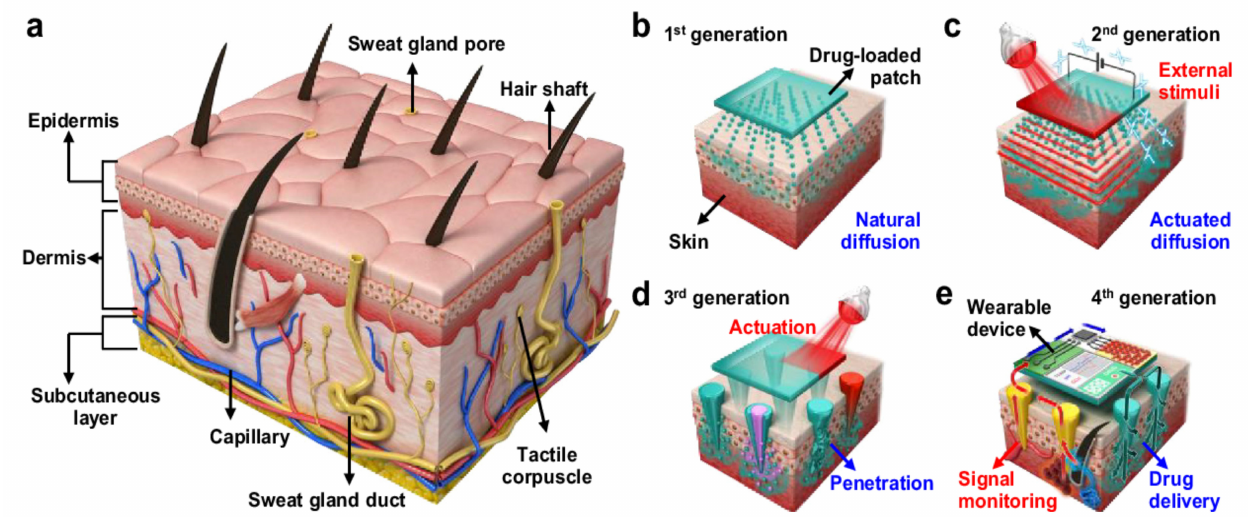
Figure 2. ( a ) Schematic illustration of the human skin. ( b ) First-generation transdermal drug delivery technology via natural diffusion of drugs. ( c ) Second-generation transdermal drug delivery technology for actuated drug delivery via external stimulation. ( d ) Third-generation transdermal drug delivery technology for enhanced drug transport via microneedle-mediated destruction of skin layer and various functionalities accompanying microneedles. ( e ) Fourth- generation transdermal drug delivery technology for patient-customized therapy with the assistance of wearable devices [18]. Reprinted from Advanced drug delivery reviews, Vol. 127, Hyunjae Lee et al., Device-assisted transdermal drug delivery, Pages 35–45, Copyright (2018), with permission from